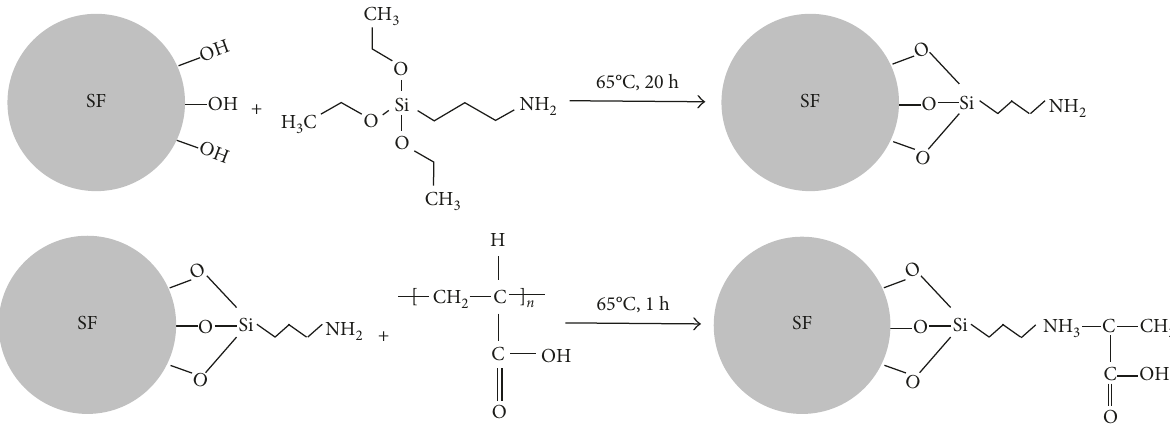
Figure 6: Schematic representation for surface modification reaction.